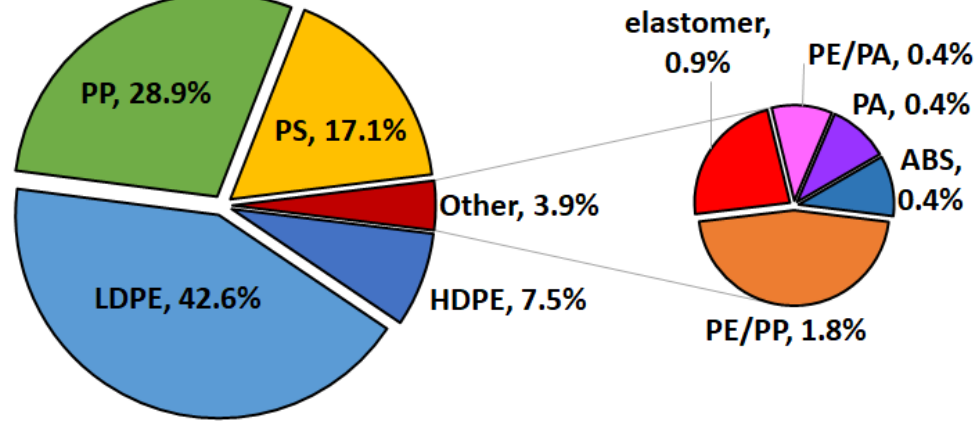
Figure 5. Composition of the analyzed plastics.